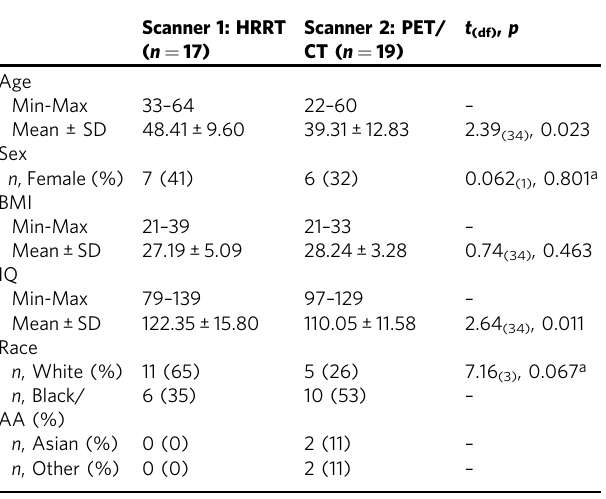
Table 1 Demographics and participant characteristics, by PET